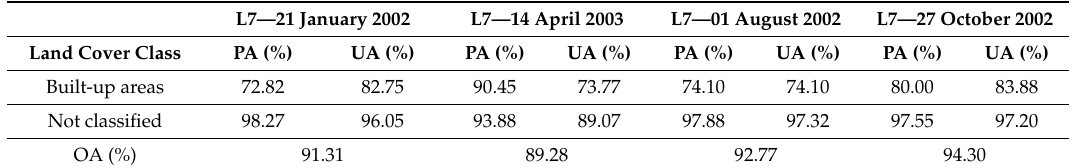
Table 16. OA, PA, and UA obtained computing SwiRed index on the images acquired by Landsat 7 mission. UA, user’s accuracy; PA, producer’s accuracy; OA, overall